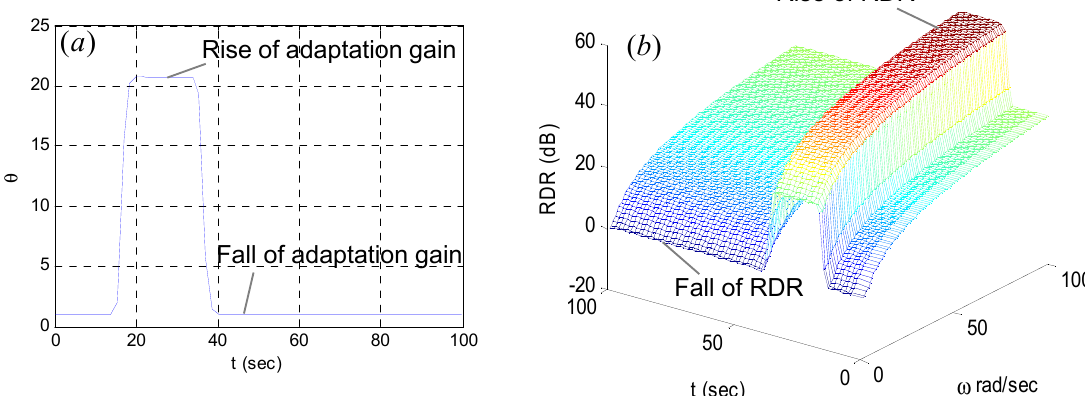
Figure 9. ( a ) Evolution of the adaptation gain θ of the ML-MR PID-MIT-CGM control structure. ( b ) Corresponding adaptive modification of the RDR spectrum of the C θ ( s ) controller in order to reject disturbances.